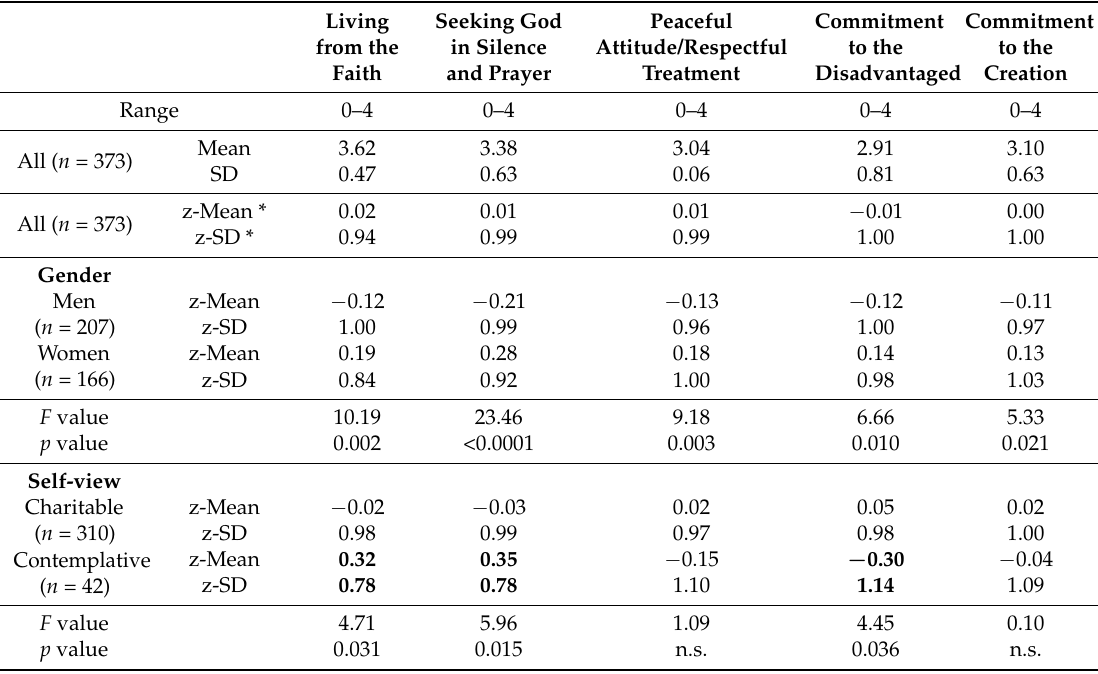
Table 3. Expression of FraSpir RO scores in the